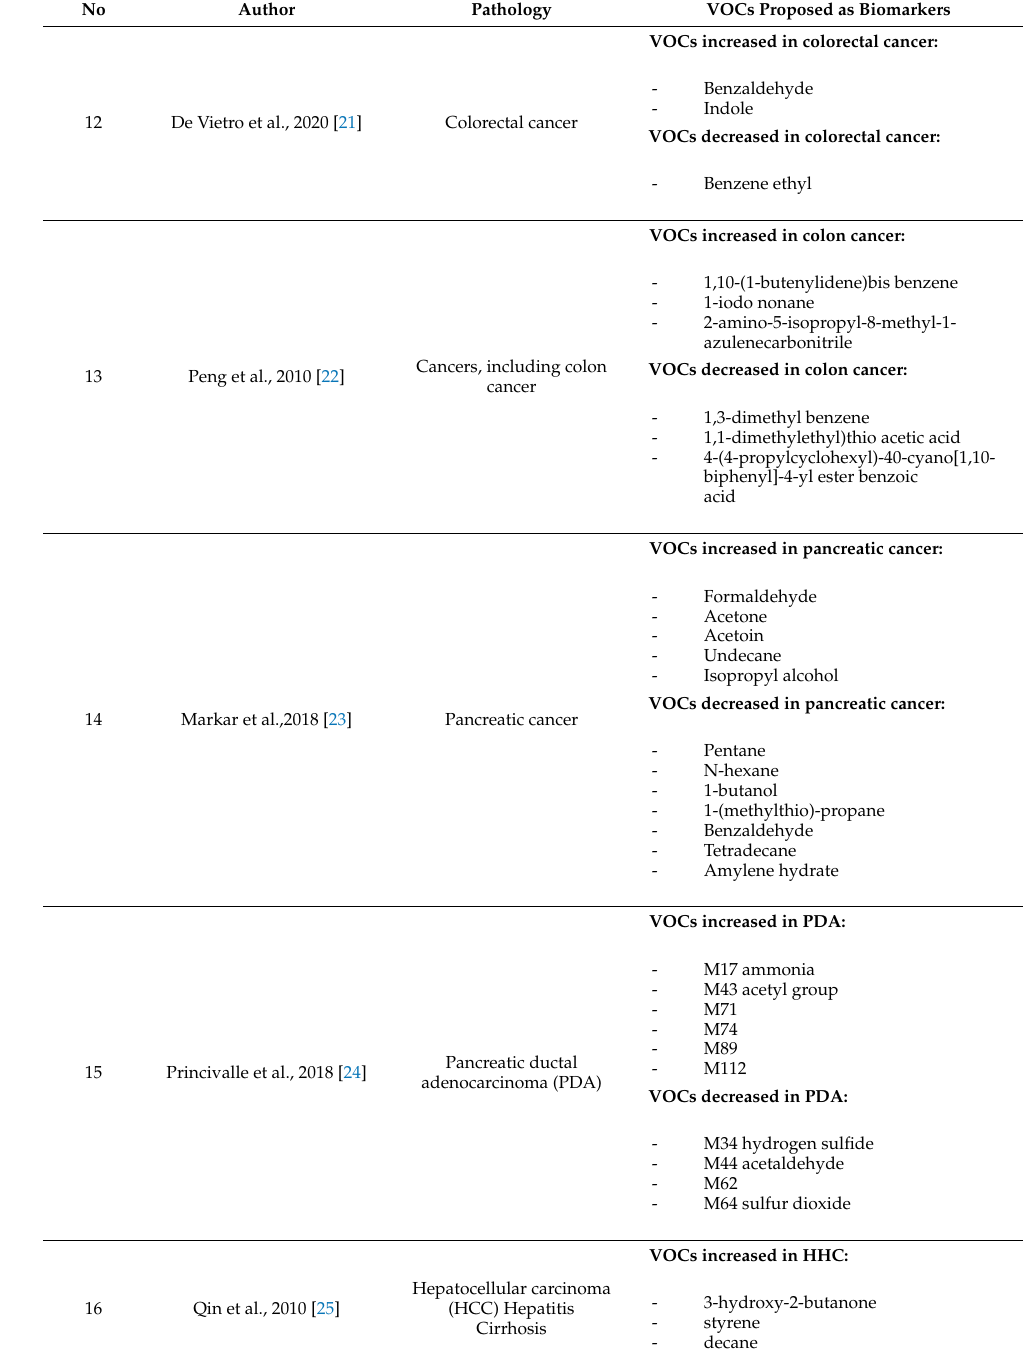
Table 2. Volatile organic compounds in digestive neoplasia: articles